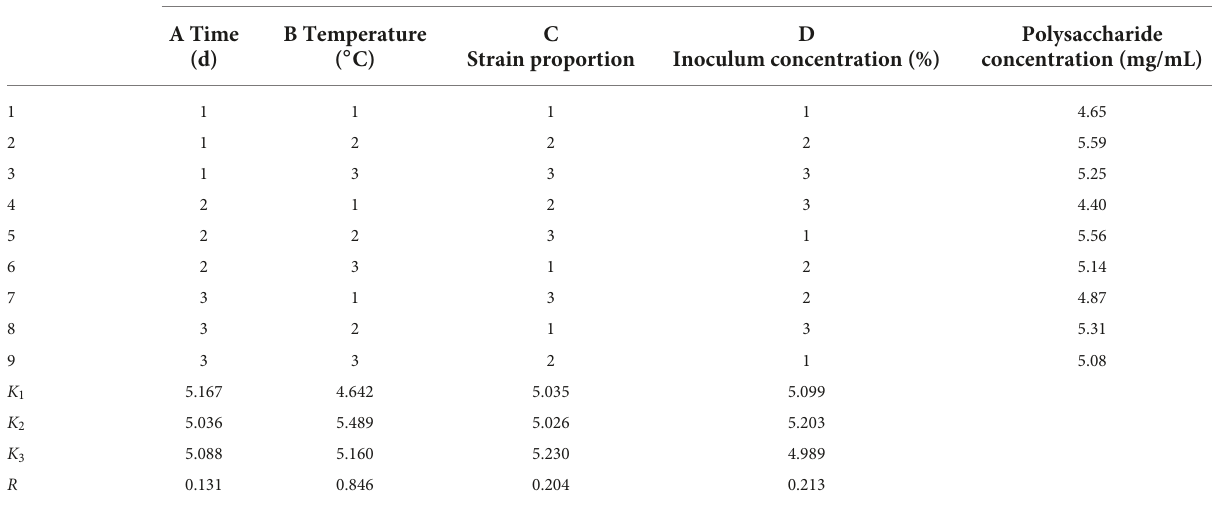
TABLE 3 The L 9 (3 4 ) orthogonal experiment design and